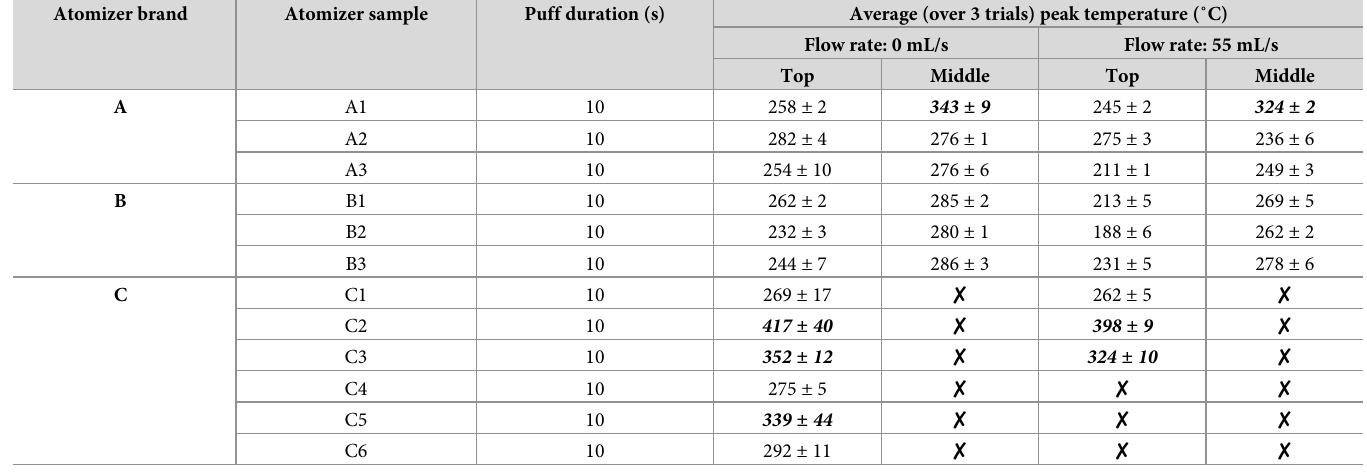
Table 1. Recorded maximum temperature by thermocouple (TC) for different brand of atomizers (Ni 200, 0.15 O ) with: Temperature control = 300 ˚C, power = 100 W, puff duration = 10 s, airflow rates of 0 mL/s and 55 mL/s. Atomizer